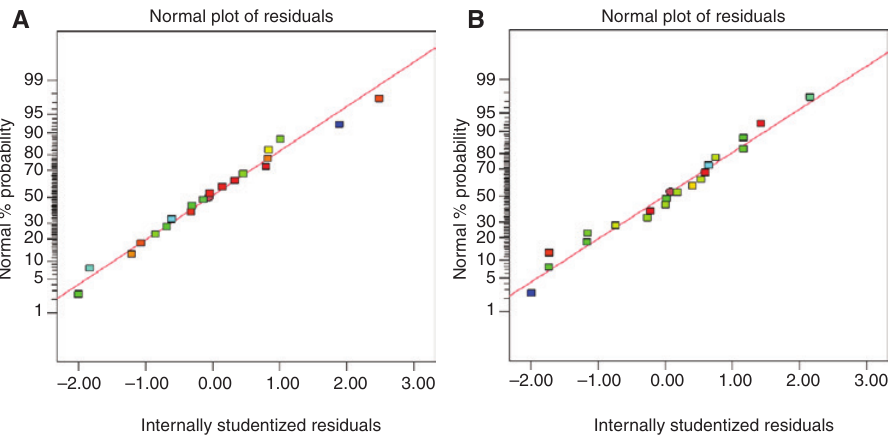
Figure 1: Normal probability plot of the residuals for the separation factor (A) and the permeation flux (B).